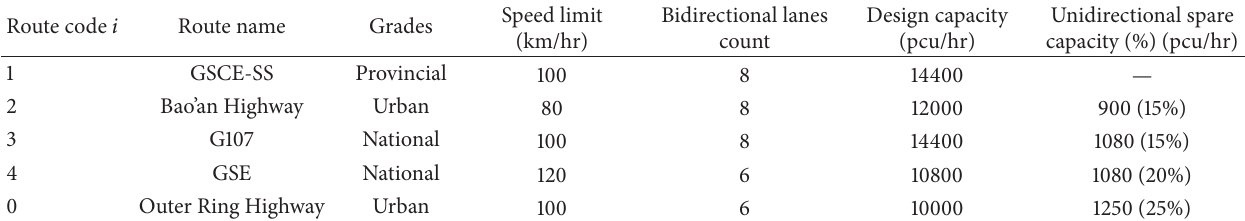
Table 2: Characteristics of primary paralleled and connected roadways related to GSCE-SS. Route code